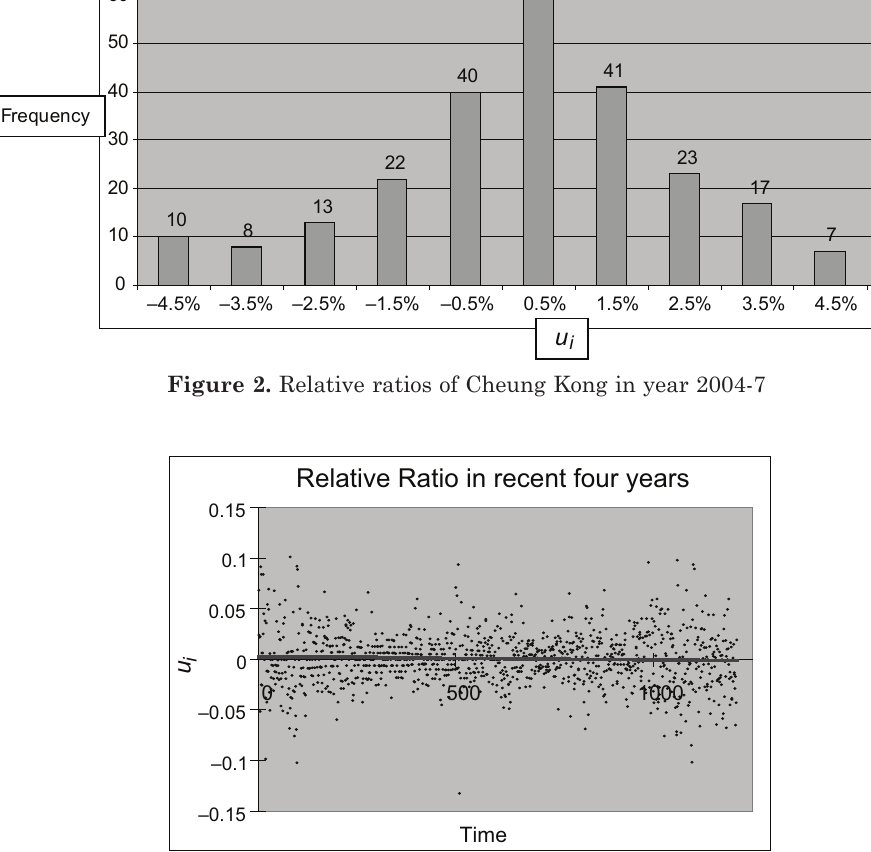
figure 3. relative ratios of Cheung Kong in year 2004-7